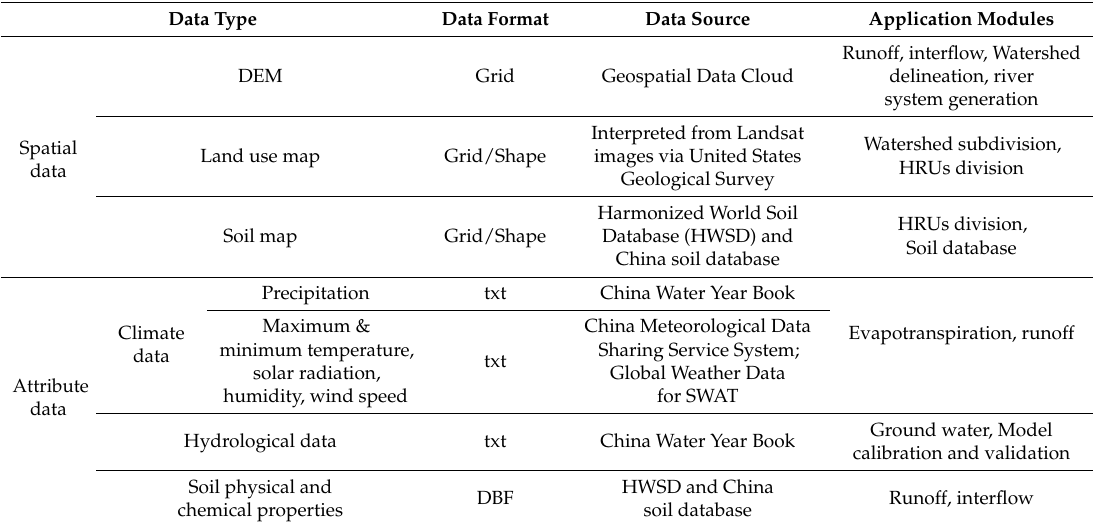
Table 1. The input data in the SWAT model.